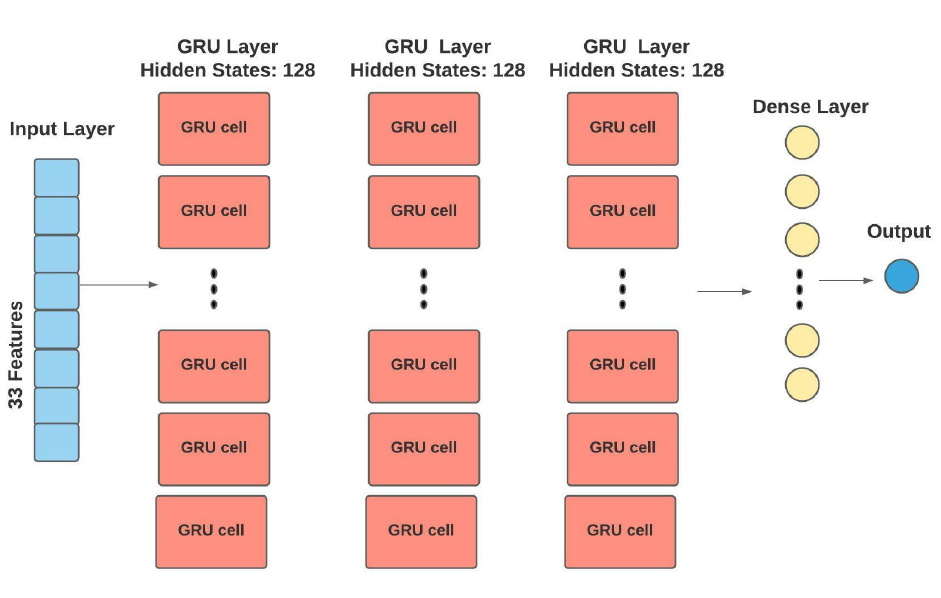
Figure 18. GRU forecasting model